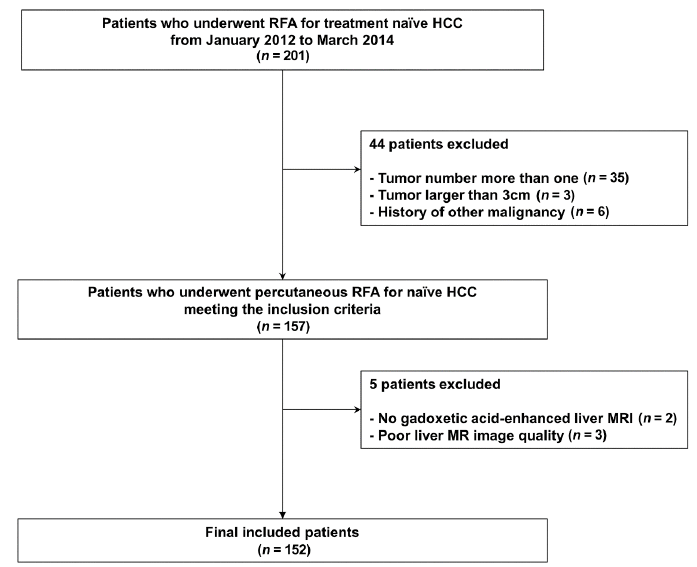
Figure 1. Patient inclusion process.